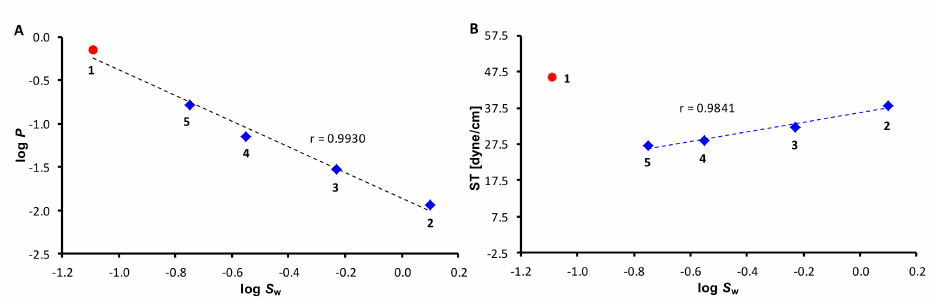
Figure 1. Dependences of lipophilicity (log P ) ( A ) and surface tension (ST) ( B ) on water solubility (log S w ).